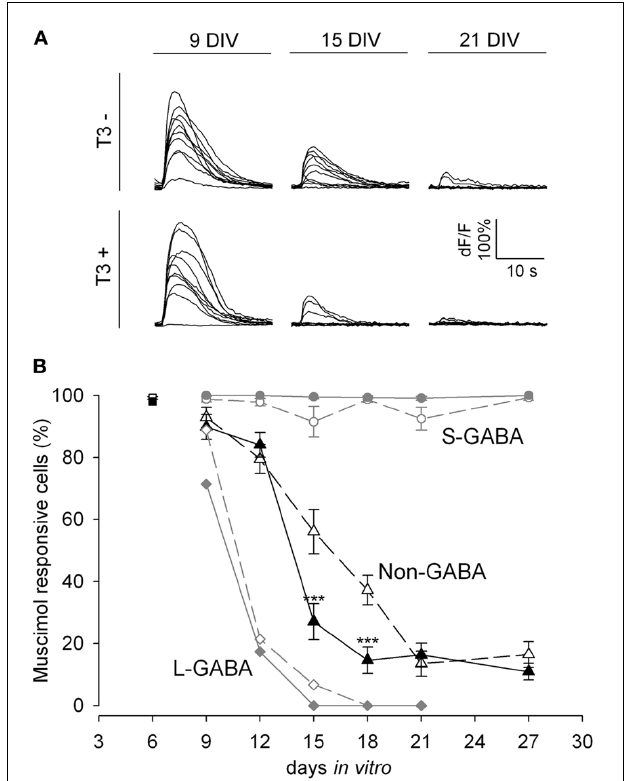
FIGURE 2 | GABA shift in T3 + and T3 − networks shown by Fluo-4 recordings. (A) . Representative calcium transients of non-GABA grown either in T3 − and T3 + in response to muscimol application at 9, 15, and 21DIV. (B) . The developmental shift from depolarizing to hyperpolarizing actions of GABA is shown by the fraction of neurons with a significant increase in fluorescence after muscimol stimulation. At 6DIV most neurons (black and white rectangles) show calcium transients after muscimol application. Only few L-GABA (diamonds) and non-GABA (triangles) can be activated by muscimol application after day 9, but all S-GABA (circles) respond to muscimol until day 27. GABAergic neuron response to muscimol was little affected by T3 treatment. In contrast, T3 treatment accelerates the developmental downregulation of depolarizing actions of muscimol in non-GABA (black